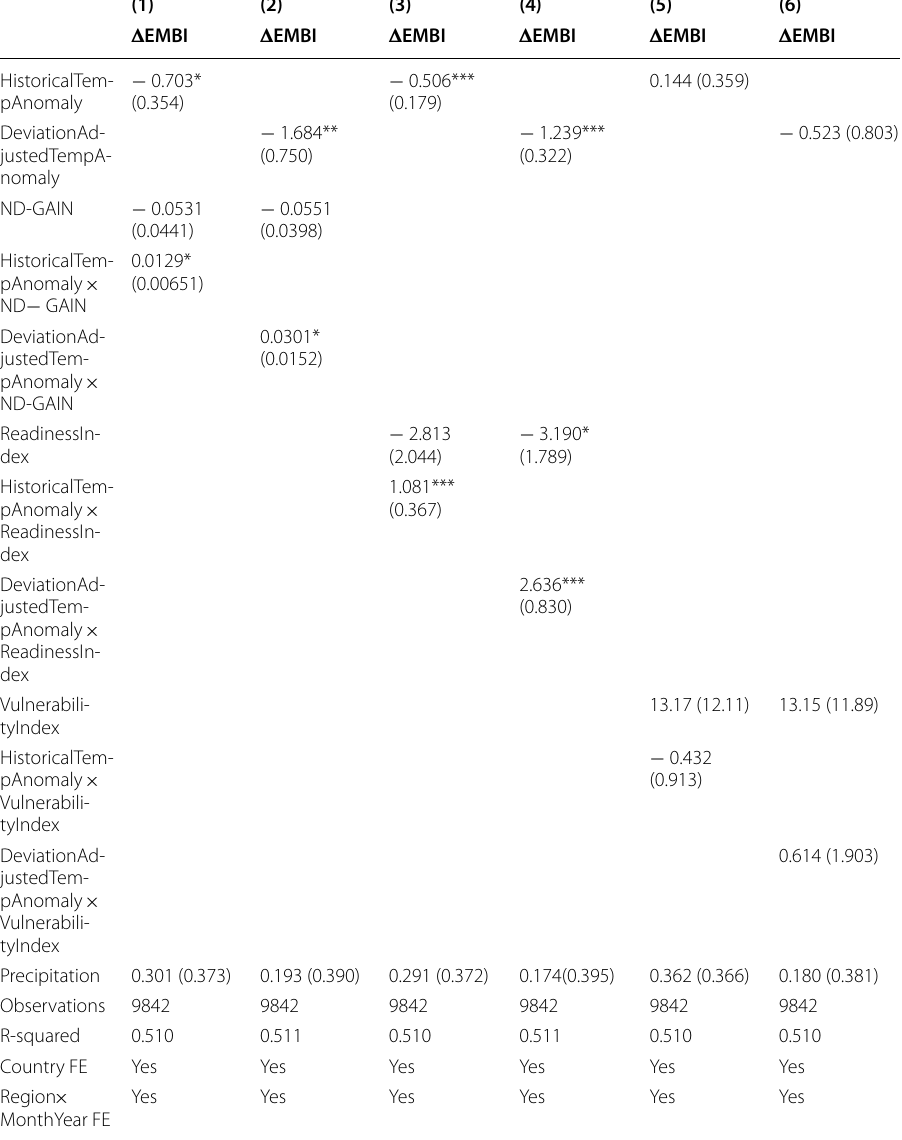
Table 10 Channels of temperature–sovereign risk connection: climate-related institutional